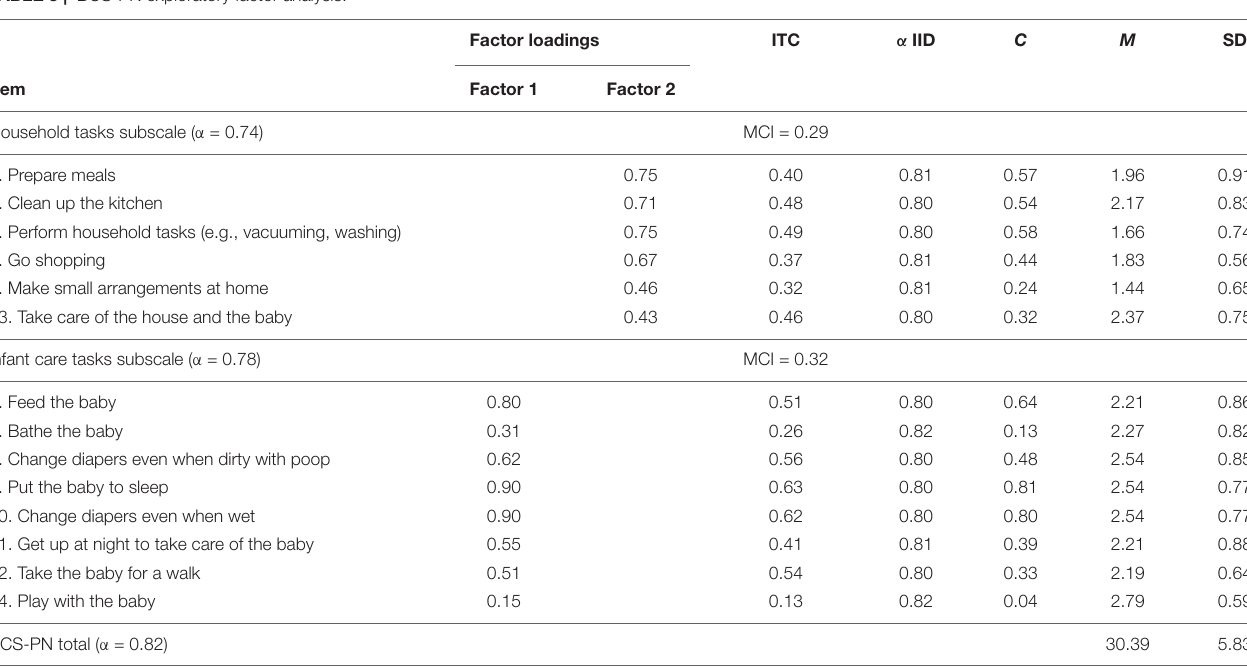
TABLE 3 | BCS-PN exploratory factor